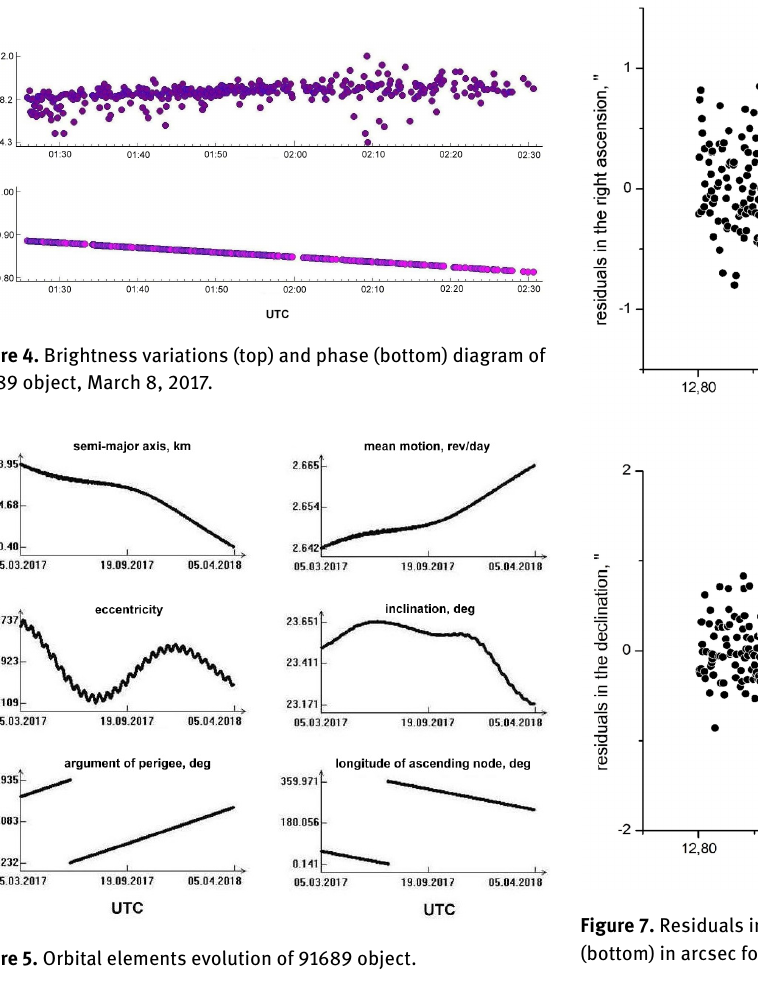
Figure 5. Orbital elements evolution of 91689 object.